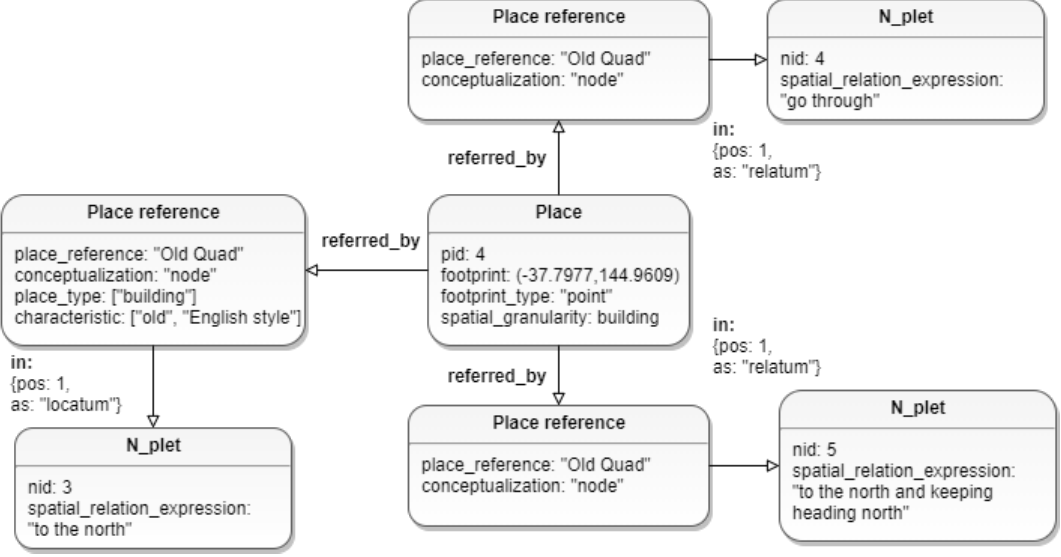
Figure A4. Linking different place reference nodes to the same place node through node merging.